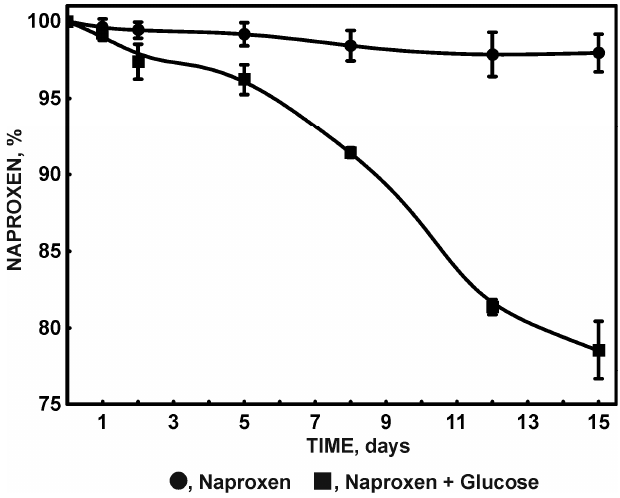
Figure 5. Degradation of 6 mg/L naproxen by strain KB2 without additional carbon source and with 0.5 mg/L glucose as a simple carbon source.